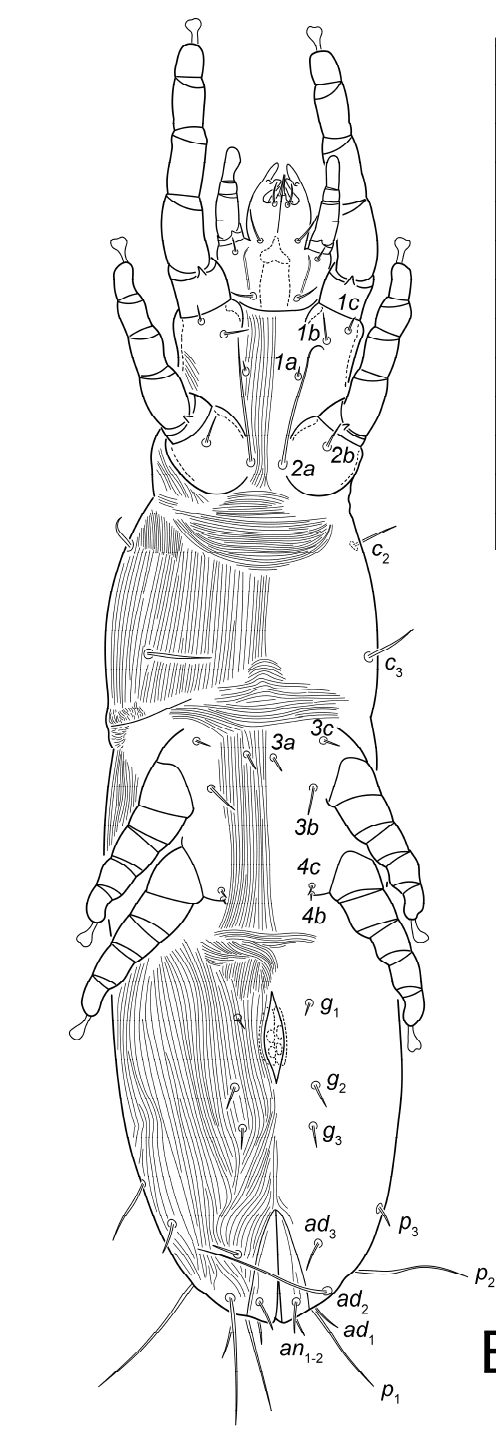
Figure 10. Paralycus daeira sp. n., tritonymph: ( A )—dorsal view; ( B )—ventral view. Scale bar 100 µm.